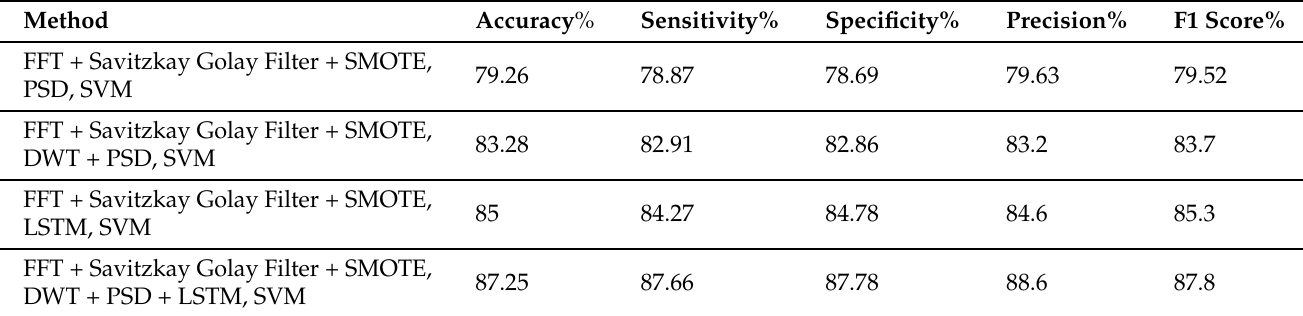
Table 4. Comparison of different feature extraction techniques applied.